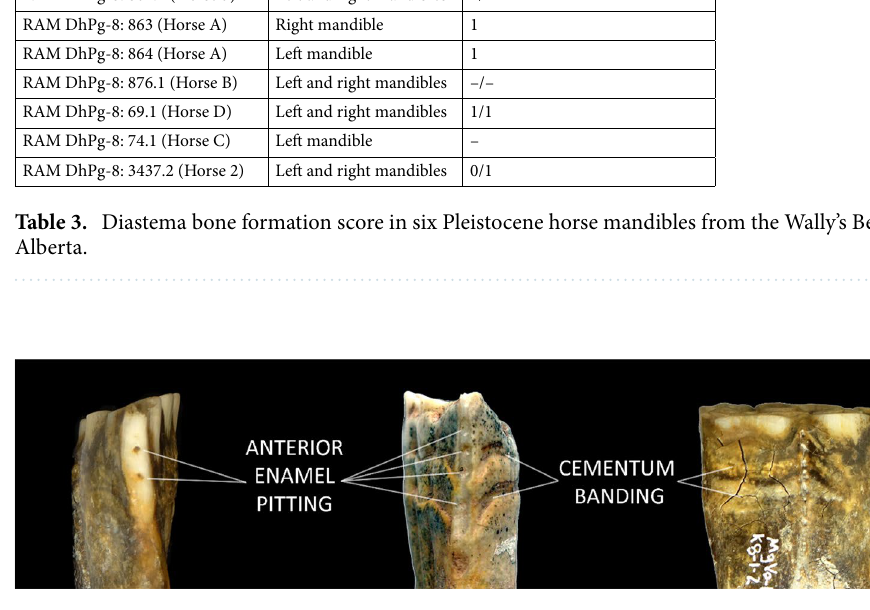
Figure 3. Comparison of the Botai “bit wear” specimen (center) with a similar tooth from a Pleistocene wild horse from North America (specimen n o MgVo-1: K8-1-2; Canadian Museum of History) that exhibits anterior enamel pits with dentine exposure (left) and cementum banding on both the buccal surface (right) and the lingual surface (not